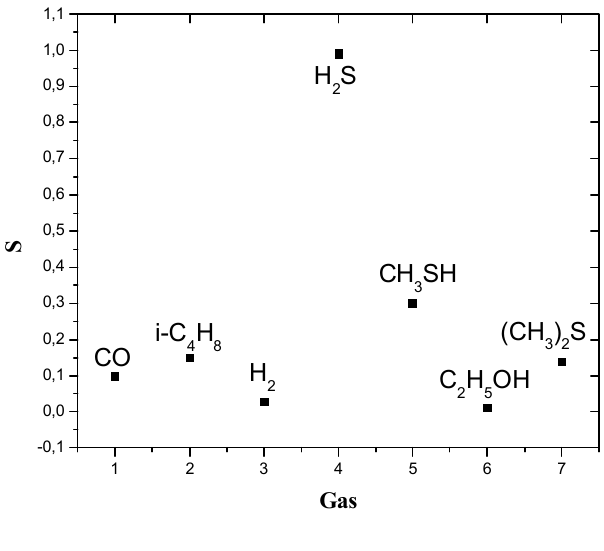
Figure 6. Cross sensitivity of CuO/SnO temperature of 100 o